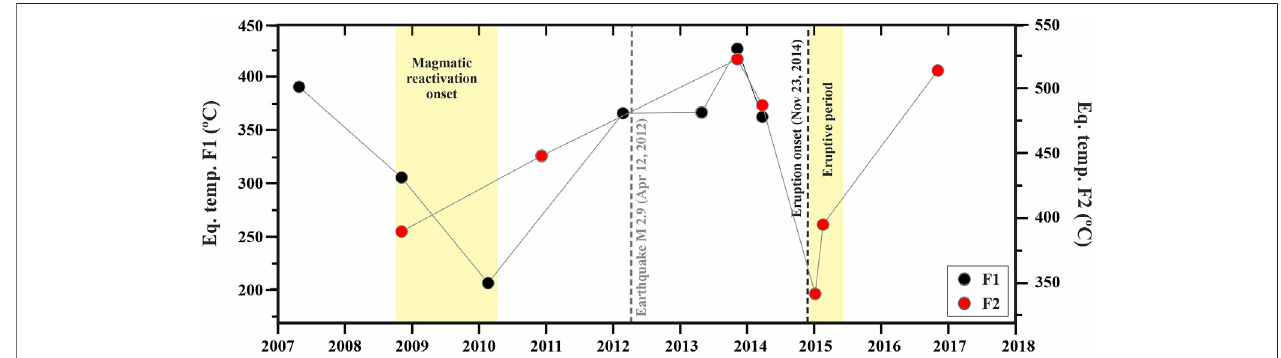
FIGURE 3 | Temporal evolution of the temperature evaluated in the equilibrium conditions CH 4 , CO – CO 2 (Giggenbach, 1987) of the Pico do Fogo volcano hydrothermal system.